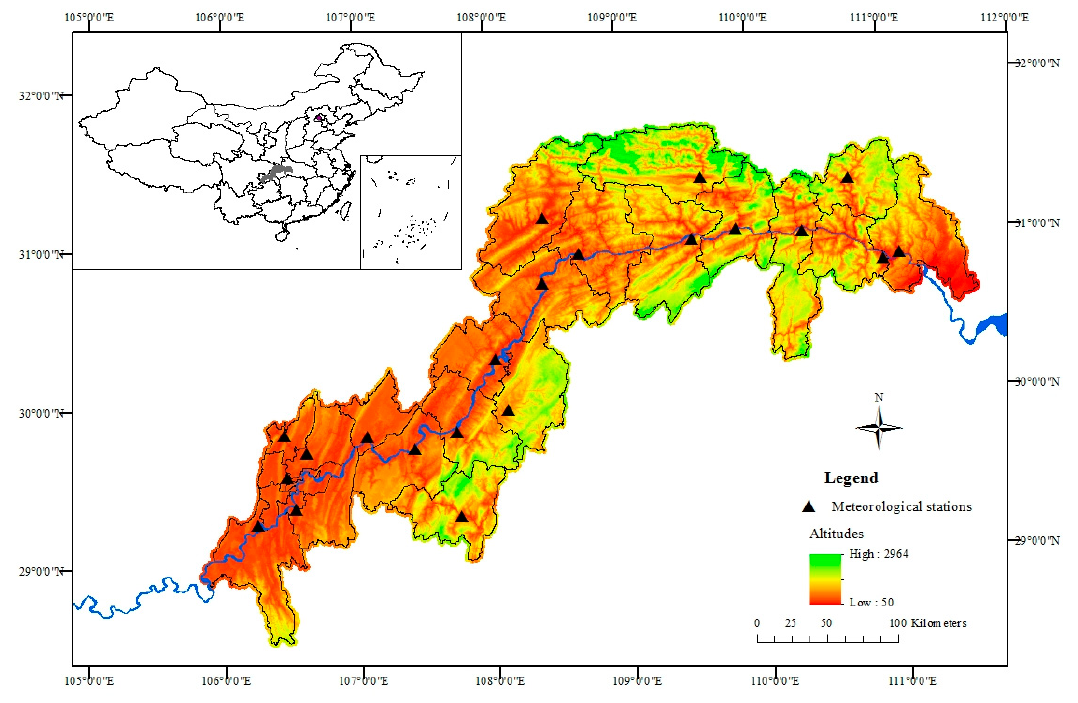
Figure 1. Location and administrative districts of the TGRA .